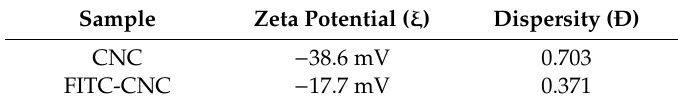
Table 1. Table summarising the zeta potential ( ξ ) and dispersity (Ð) of CNC and FITC-CNC.